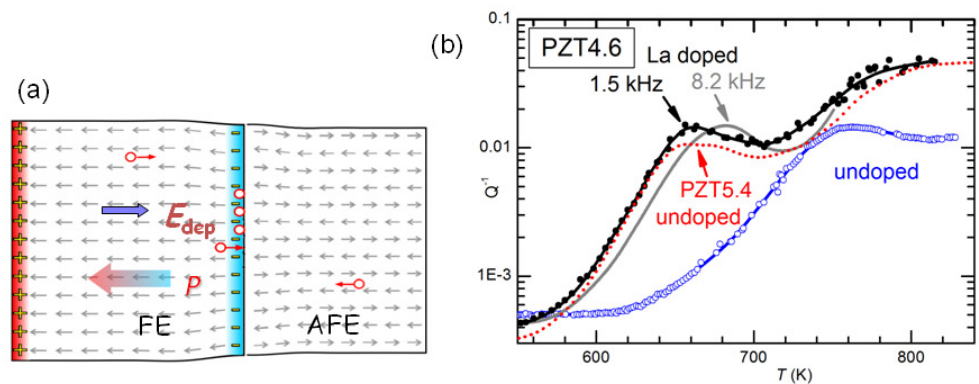
Figure 12. ( a ) Schematic representation of two neighbouring FE and AFE domains. The gray arrows are the microscopic electric dipoles; the actual AFE pattern in PZT is more complicated. The wall between the two domains is a source of inhomogeneous stress, due to the different cell volumes, and electric field, due to the polarization charge, and for both reasons attracts V O ; ( b ) Elastic energy losses of PZT4.6 (empty symbols) PZT4.6 doped with 2% La (closed symbols and continuous line measured at higher frequency) and PZT5.4 (dotted line) (some data from Ref.